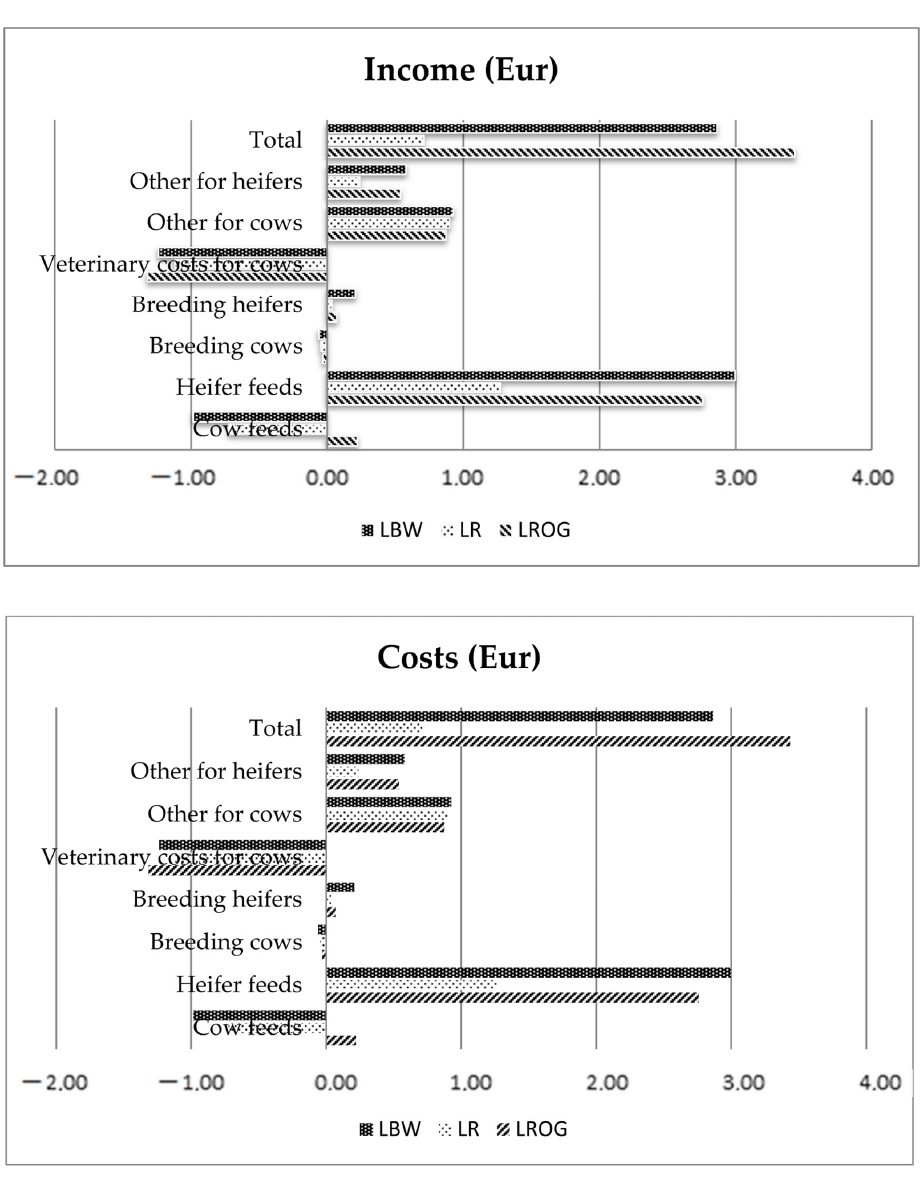
Figure 4. Economic income and costs (in Euro) caused by an increase in cow mortality rate of 1 percentage point for the breeds LBW, LR and LROG.